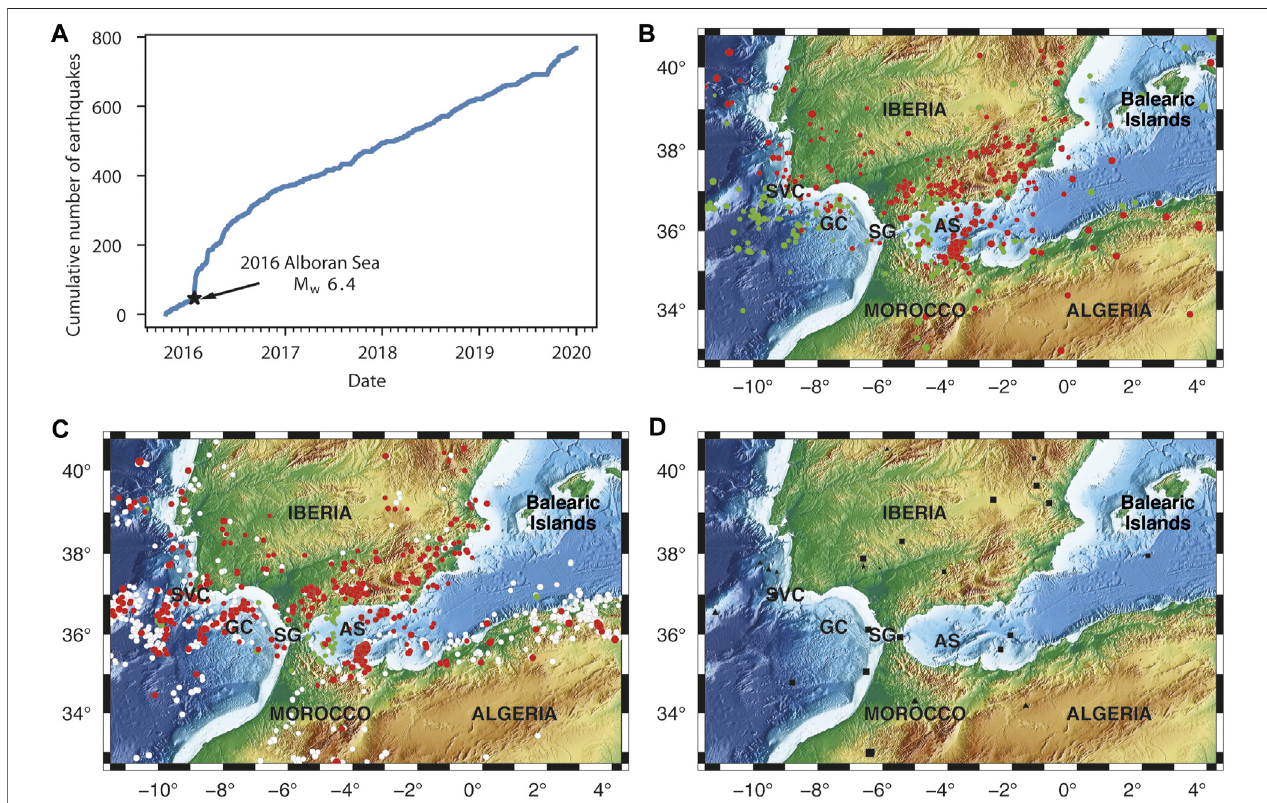
FIGURE3|(A) CumulativenumberofearthquakesdetectedbyPRESTofromOctober2015toDecember2019. (B) EpicentersdetectedbyPRESTOfrom2016to 2019. (C) ComparisonbetweentheepicentersdetectedbyPRESToandIGN(inred)andonlybyIGN(white). (D) PRESTofalsedetections(blacksquares),explosionsin mines (stars), or lost earthquakes (triangles). Acronyms same as those in Panel 1